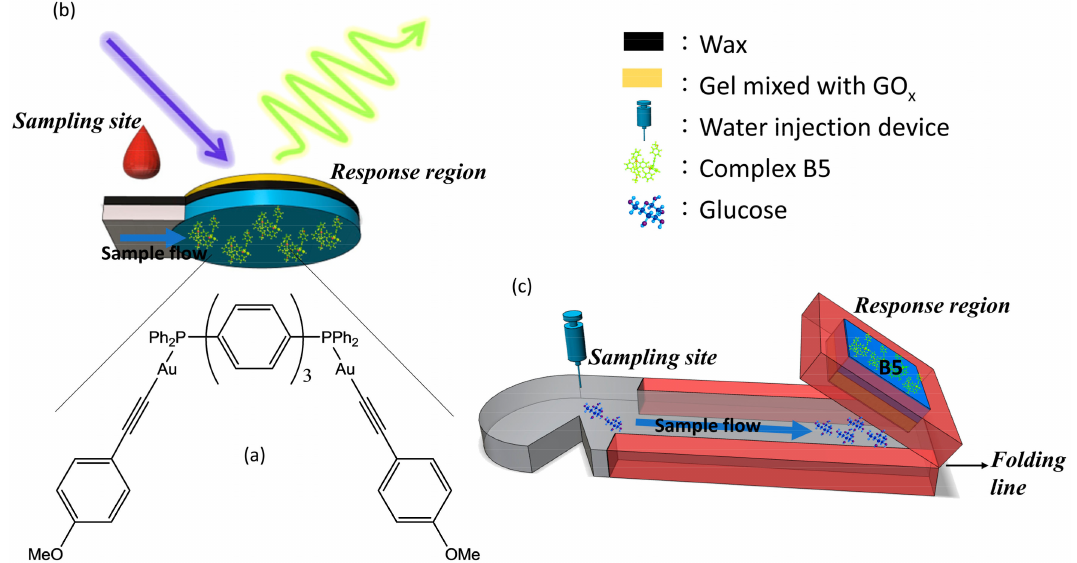
Figure 1. ( a ) Structure of B5 , ( b ) a schematic illustration of luminescent and microfluidic paper-based analytical device ( µ PAD) for blood glucose; blue disk is the circular region of enzyme loading in the cellulose paper, and ( c ) a Schirmer strip for tear glucose